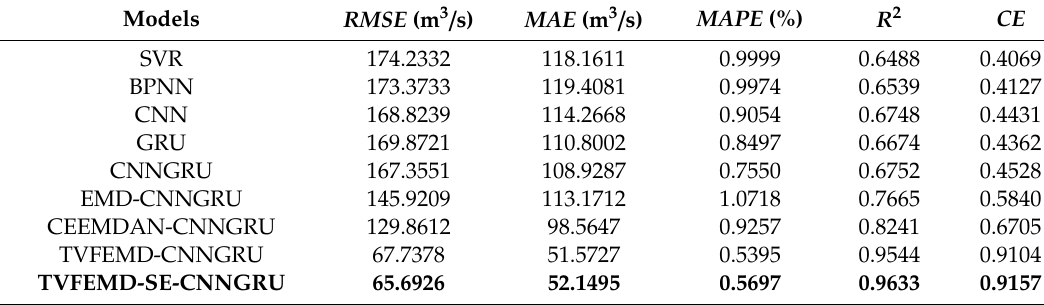
Table 5. Evaluation metrics of all the experimental